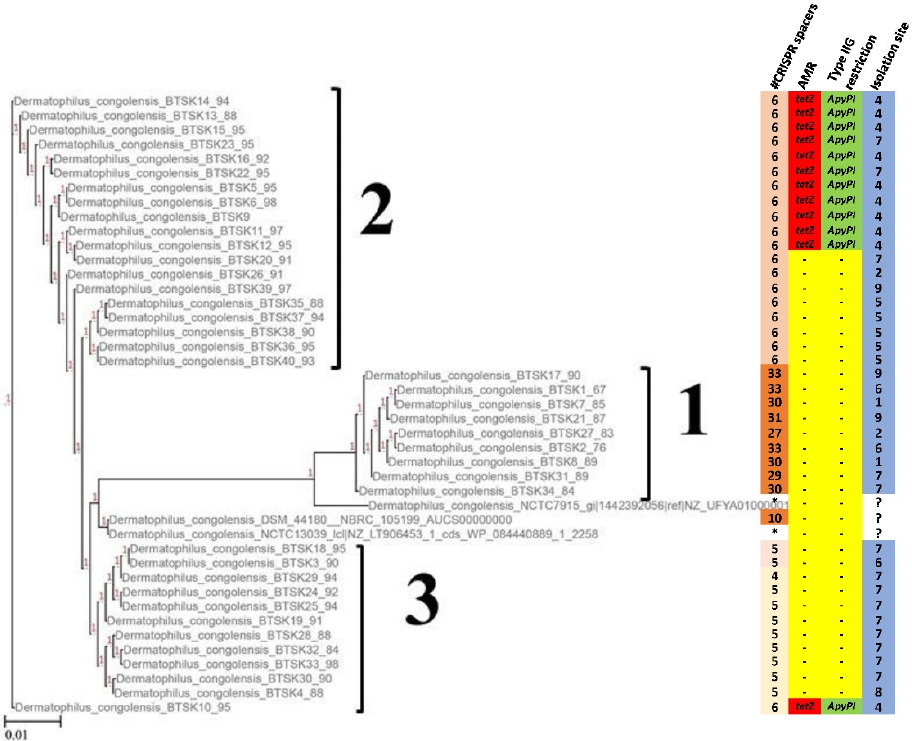
Figure 4. D. congolensis phylogeny. The phylogeny was inferred with the SNP calling procedure as described by Kaas et al. [16]. Three clusters are shown: cluster 1—genomes of strains isolated from different geographical locations on the island but having in common the higher number of CRISPR spacers (27–33); cluster 2—genomes of strains isolated in a single geographical location on the Island, and 11 of the genomes in the cluster are tet (Z) positive. All genomes in this cluster have 6 CRISPR spacers; cluster 3—genomes in cluster 3 of strains isolated in two geographical locations and have 5–4 CRISPR spacers. *—not detected, ?—origin not precisely described, “-“—not present.